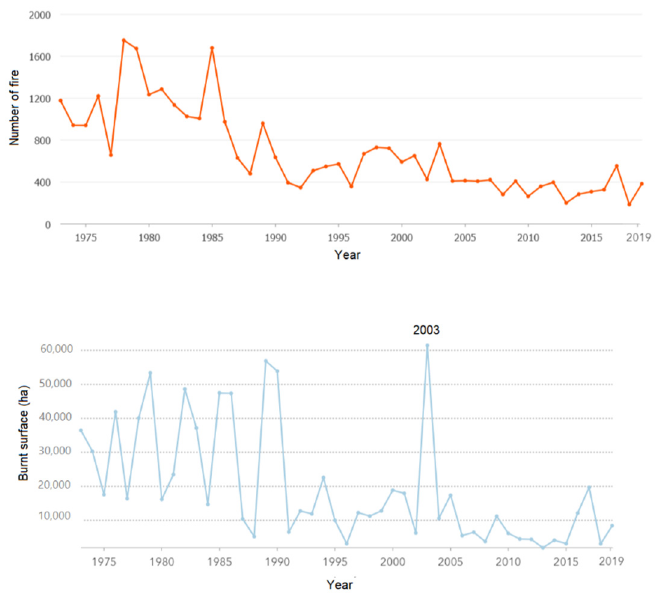
Figure 4. The occurrence and surface area of fire events tend to decrease over time, especially since